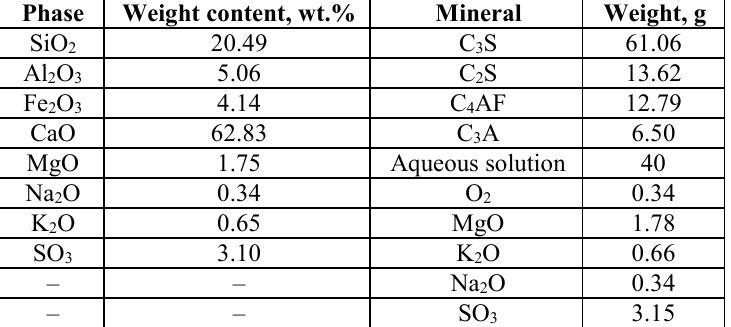
Table 1. Composition of the type CEM I 42.5B Portland